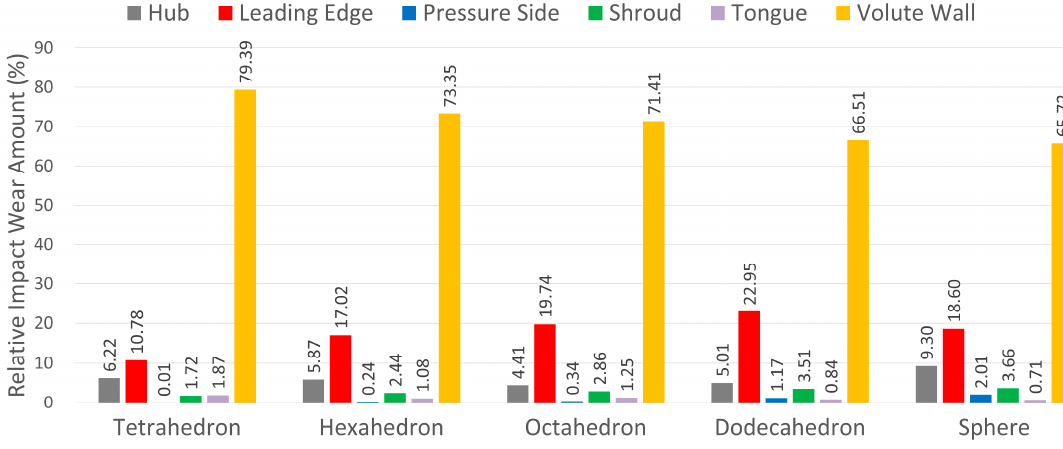
Figure 8. Relative impact wear amount of flow parts.